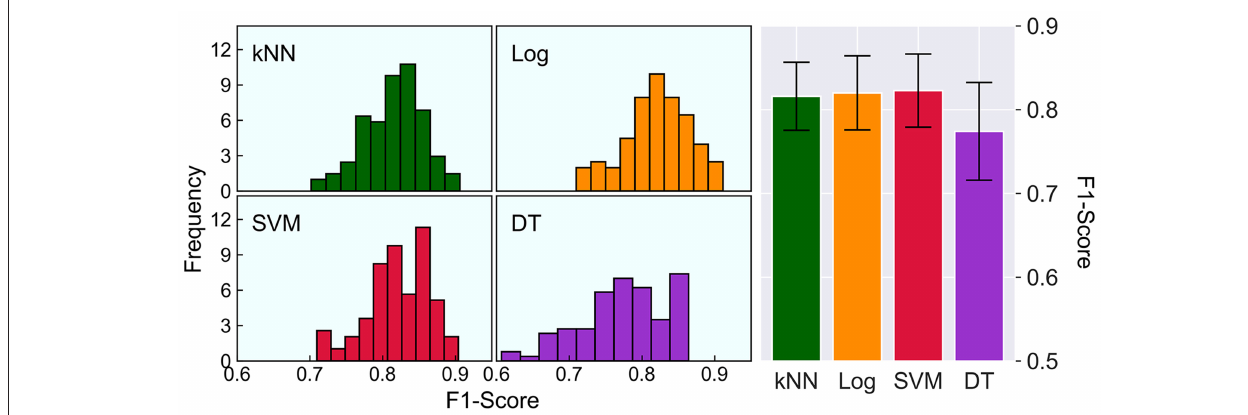
FIGURE 1 | Comparison on F1-scores of the four models. The left histograms show the distribution of the F1-score, and the right bar chart shows a direct comparison on the F1-scores of kNN (0.816 ± 0.041), Log (0.820 ± 0.044), SVM (0.823 ± 0.044) and DT (0.774 ± 0.059). The error bars represent one standard deviation of uncertainty. kNN, k-nearest neighbors; Log, logistic regression; SVM, support vector machine; DT, decision tree.